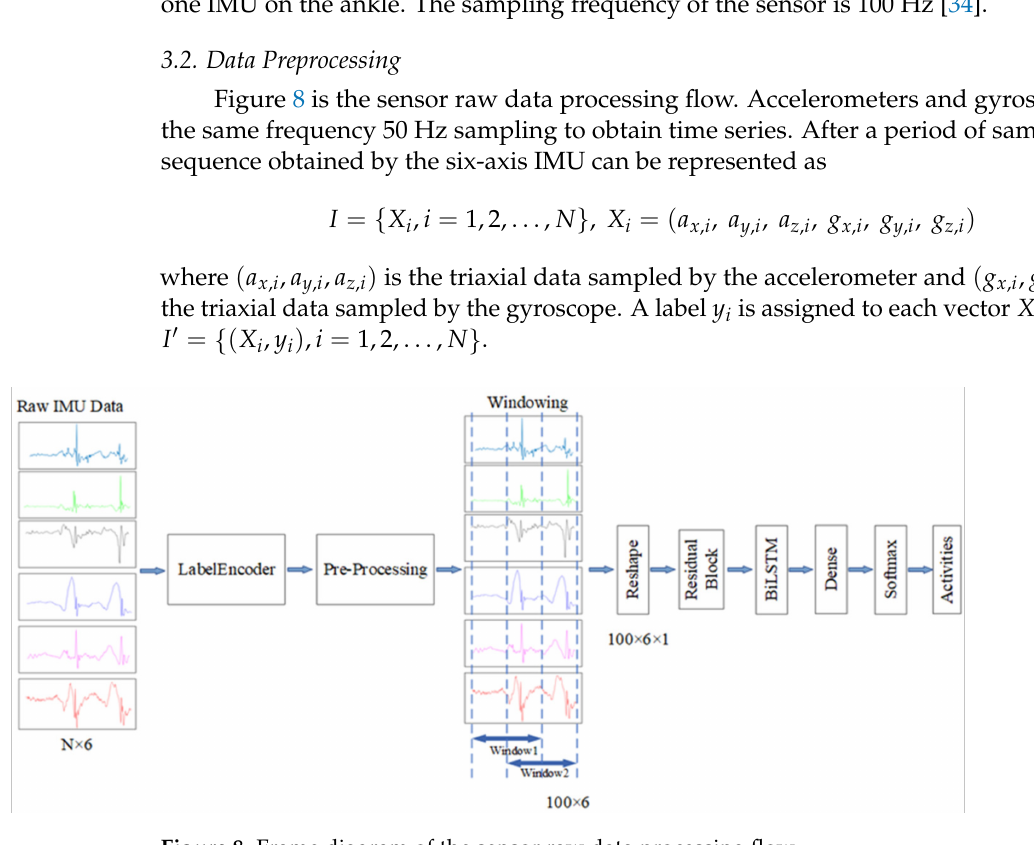
Figure 8. Frame diagram of the sensor raw data processing